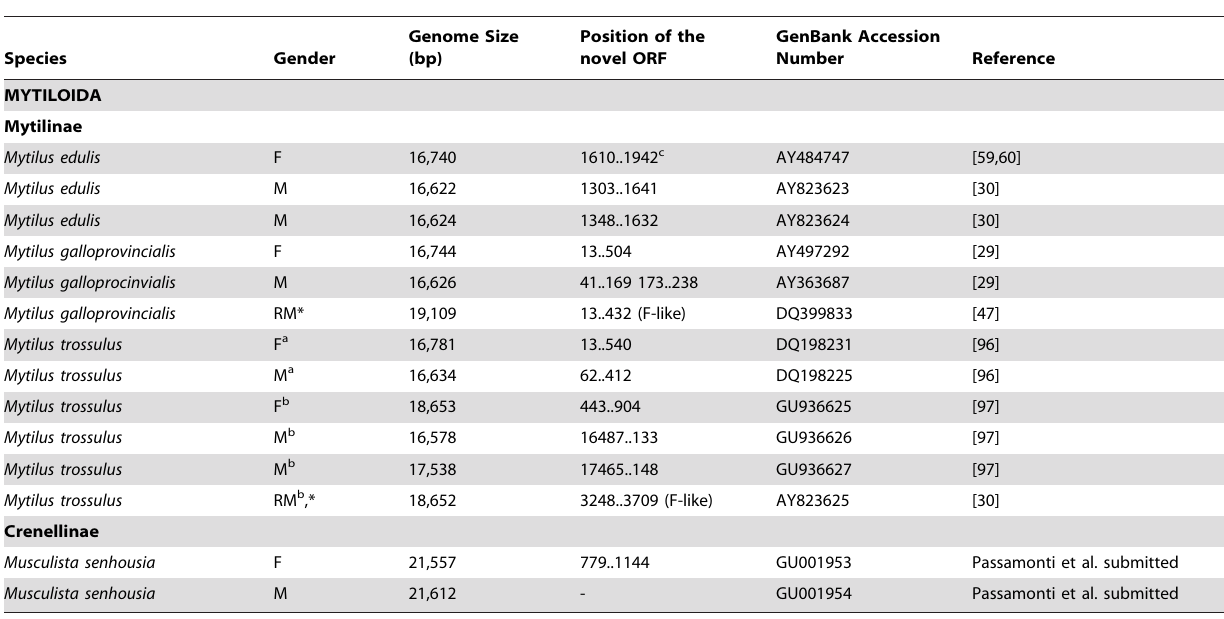
Table 1. Complete mitochondrial genome sequences of mytilid species with DUI used in this study.